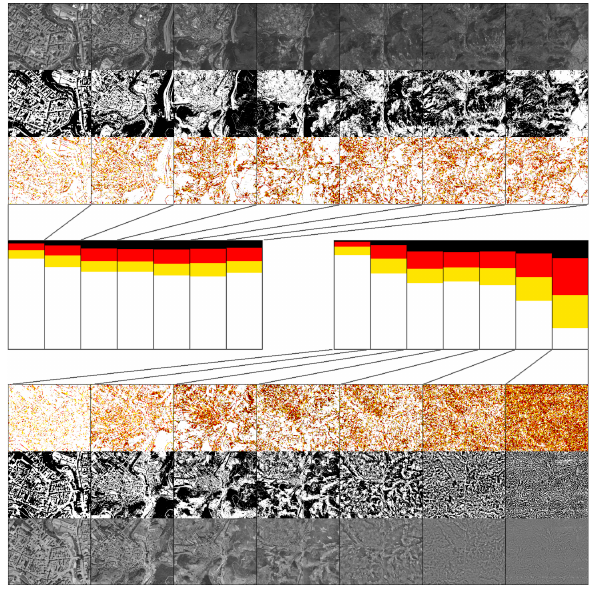
Figure 4. From left to right, orthoimages of the same location considered at decreasing scales. On the top, images from 2006-2010 corrected with physical method. On the bottom images from 1950-1965 corrected with Wallis filtering. In the middle, their respective multi-scale scores: in red and brighter, proportion of pixels that are invariant by opening and closing with a 3 × 3 pixels structuring element, in yellow and brighter, the same with 5 × 5 and in white, with 7 × 7.